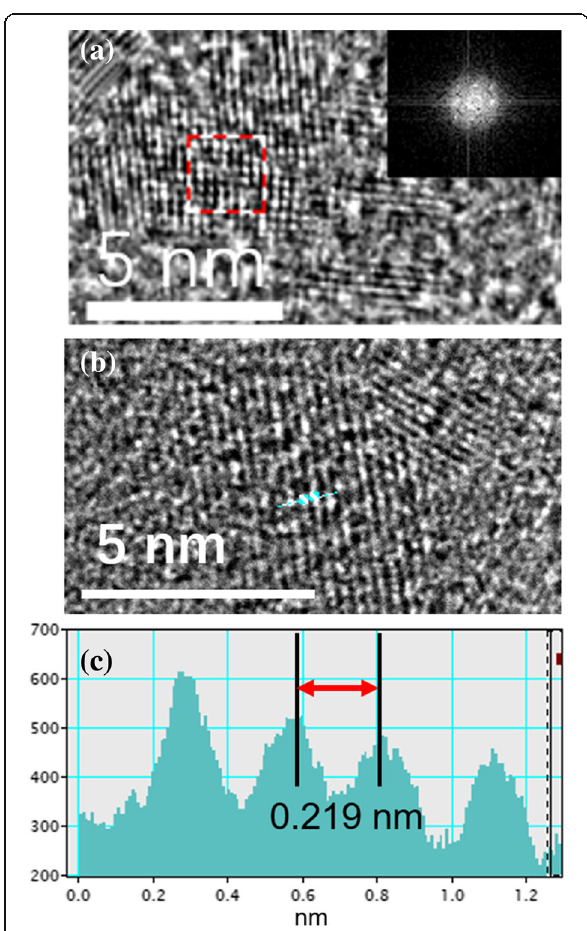
Fig. 2 a HRTEM images of nano-graphene. Inset: FFT image of a selected area. b HRTEM and c line profile of the selected nano-graphene